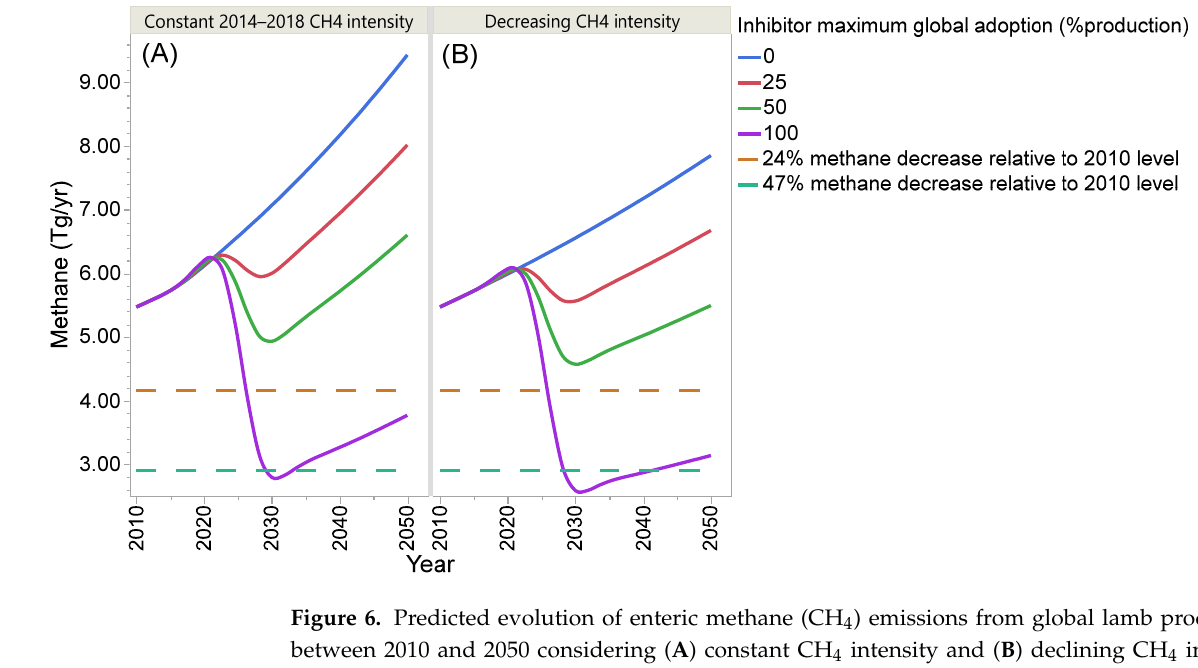
Figure 6. Predicted evolution of enteric methane (CH 4 ) emissions from global lamb production between 2010 and 2050 considering ( A ) constant CH 4 intensity and ( B ) declining CH 4 intensity according to Table 1. Adoption of feed additive inhibitors of methanogenesis decreasing CH 4 intensity by 60% is simulated to occur at 0, 25, 50, or 100% of global lamb production. Decreases in enteric CH 4 emissions of 24 and 47% relative to 2010 required to maintain a global temperature increase within 1.5 ◦ C according to different socioeconomic scenarios and climate models [15] are shown in dashed lines.